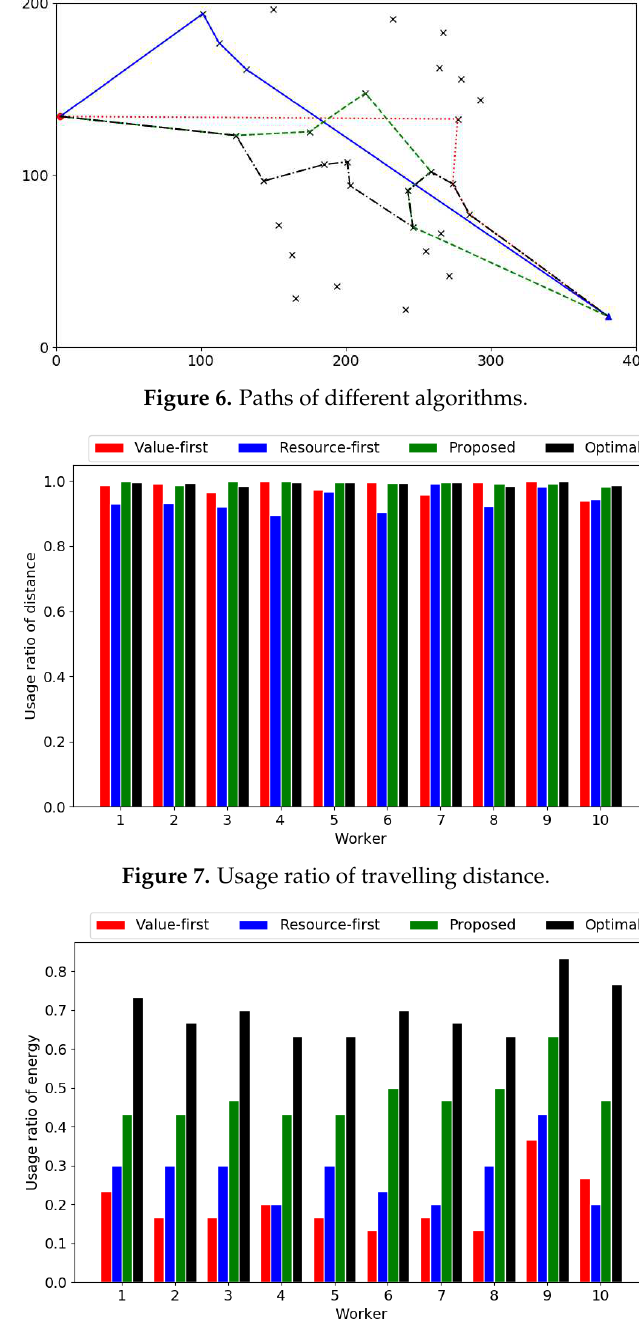
Figure 8. Usage ratio of